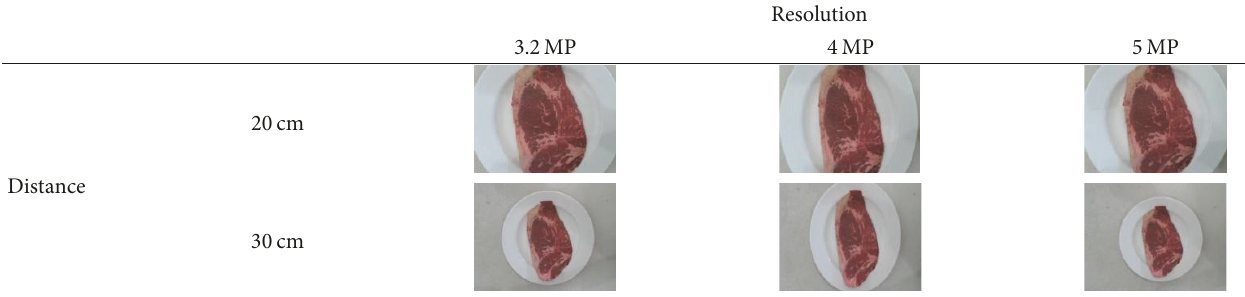
Table 1: Samples of beef image from varied camera distance and resolution.